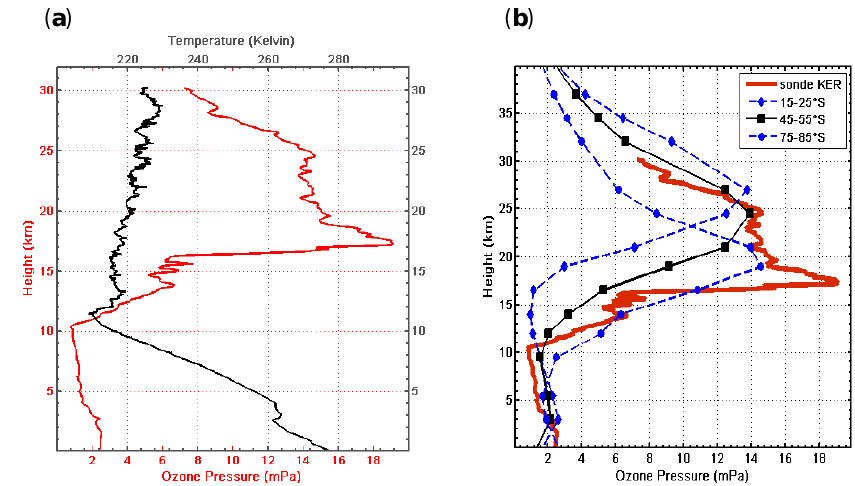
Fig. 1. (a) Vertical profiles of temperature (black line, in Kelvin) and ozone (red line, in mPa) obtained over Kerguelen (49.4 ◦ S, 70.3 ◦ E) as measured by the first balloon-sonde with ozone ECC sensor on 16 April 2008. (b) Same ozone profile (partial pressure in mPa, red continuous thick line) superimposed together with climatological ozone profiles derived from Fortuin & Kelder ozone climatology for three separate latitudinal belts (15 ◦ –25 ◦ ; 45 ◦ –55 ◦ and 75 ◦ –85 ◦ ) of the Southern Hemisphere (see